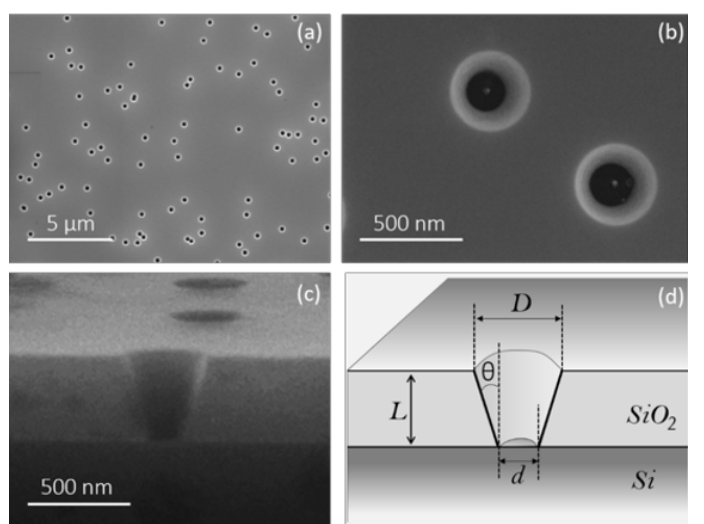
Fig. 1. (a – b) SEM images of porous SiO 2 /Si template surface at different magnifications; (c) SEM image of the SiO 2 /Si ion-track template cross-section; (d) schematic representation of main pore parameters: D – upper pore diameter; L – silicon oxide thickness after etching; d – internal pore diameter; θ – half-pore angle.